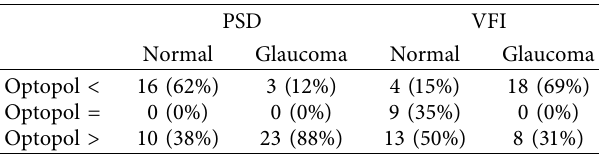
Table 2: The number of times (with the percentages in parentheses) that the reading from the Optopol machine was less than, equal to, or greater than the reading from the Zeiss machine. PSD VFI